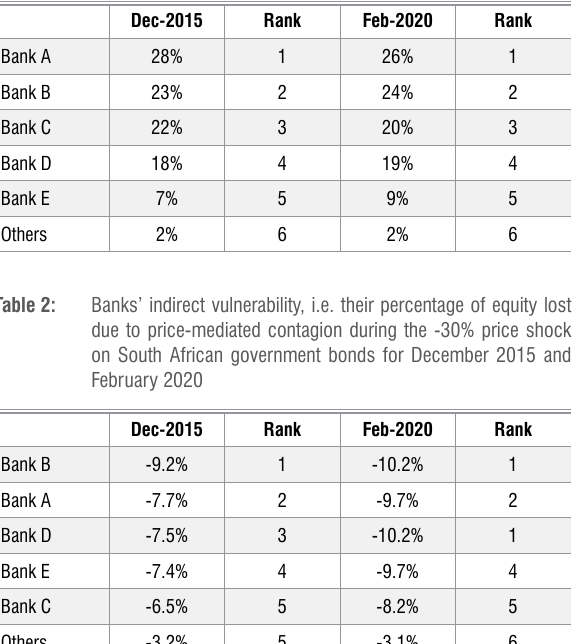
Banking sector vulnerabilities, i.e. their contribution to banking sector equity losses, in the -30% shock scenario on South African government bonds for December 2015 and February 2020. Bank A is still the most ‘systemic’, contributing approximately 26% of total banking sector equity losses arising from price spillovers in 2020.